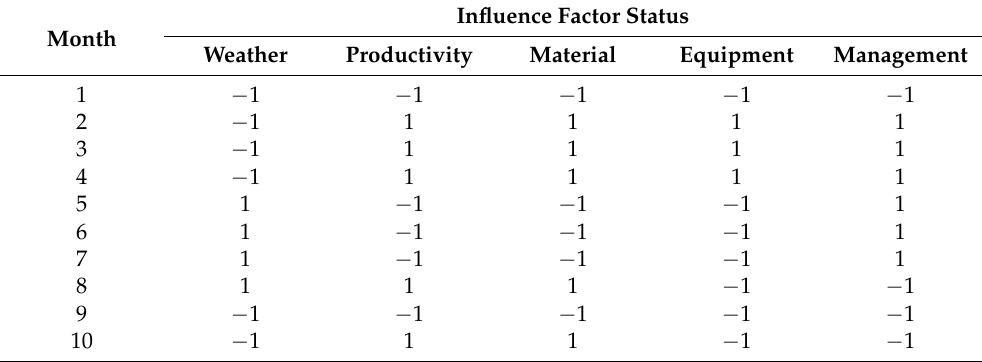
Table 4. Assessment Data at SRC